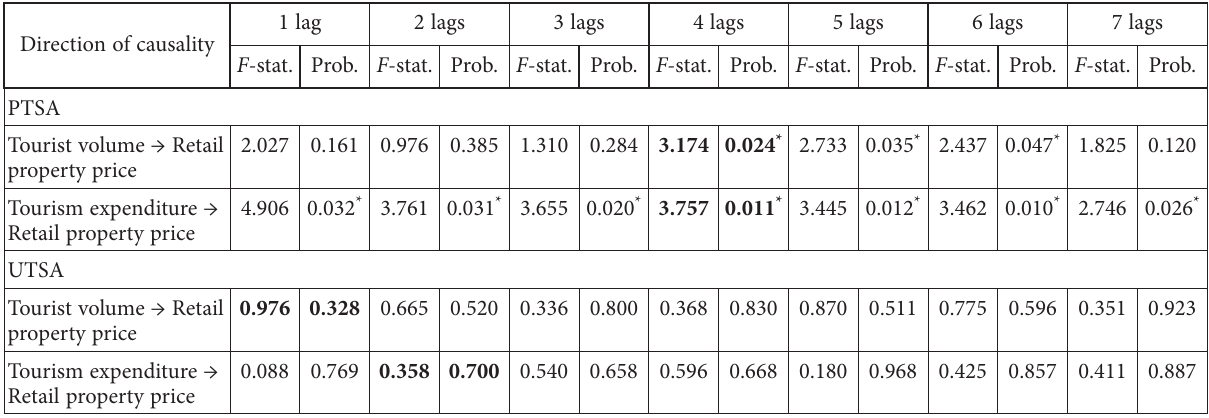
Table 3. Results of standard Granger causality tests for the two areas